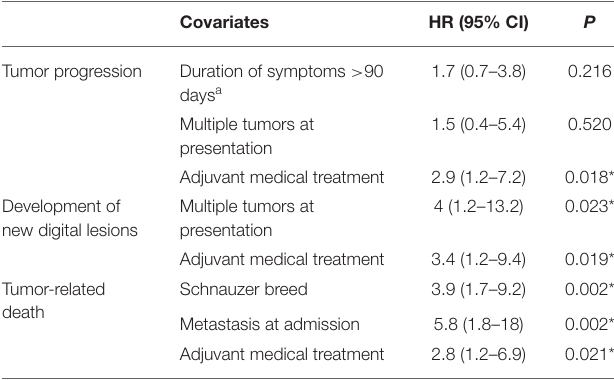
TABLE 3 | Multivariable Cox regression analysis of variables potentially associated with increased risk of tumor progression, de novo tumor development and survival time in 79 dogs with digital squamous cell